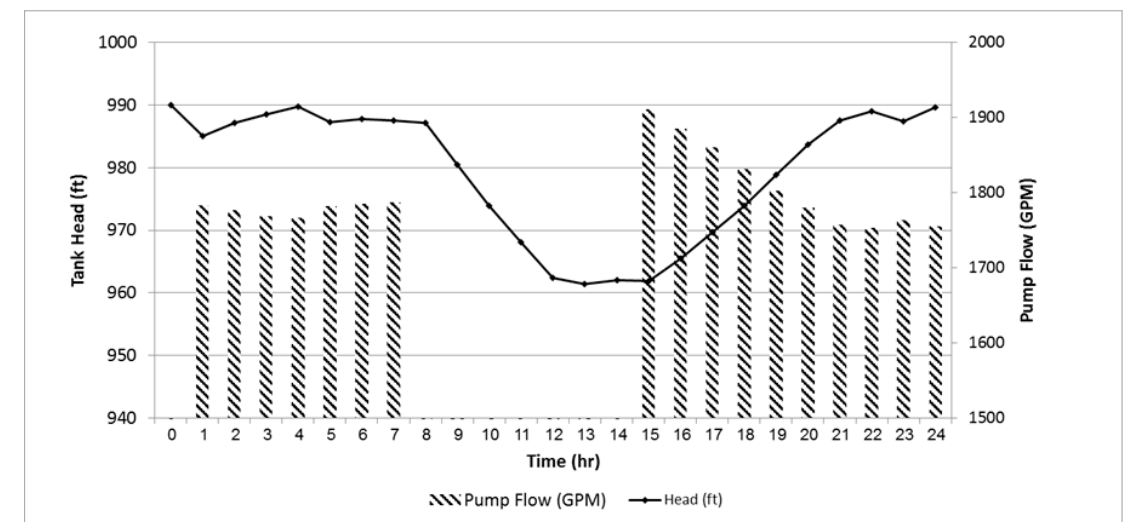
Figure 3. EPANET example 1 with classification.